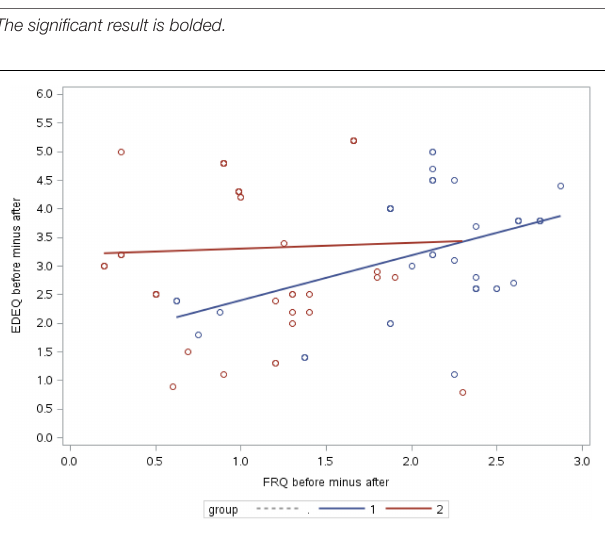
FIGURE 3 | Correlations between changes in RFQ scores and changes in EDE-Q scores (1, intervention group; 2, control group).